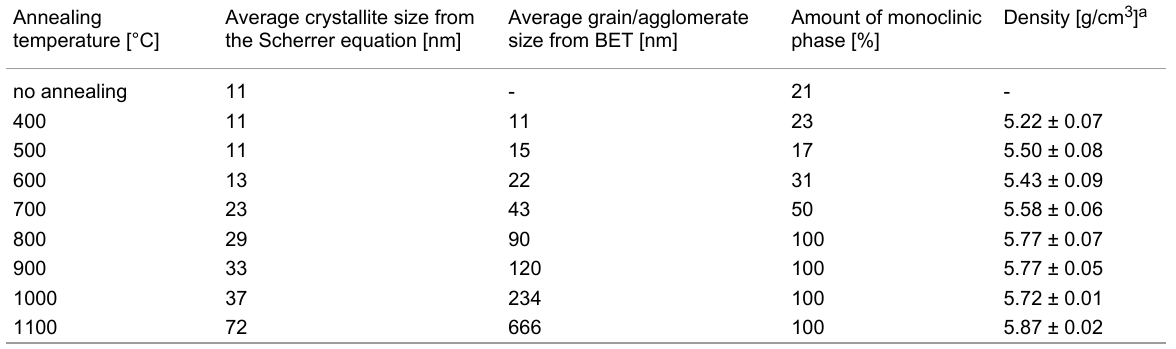
Table 1: The average grain size, density and amount of monoclinic phase as a function of the annealing temperature of the nano-ZrO 2 powders. Annealing temperature [°C]